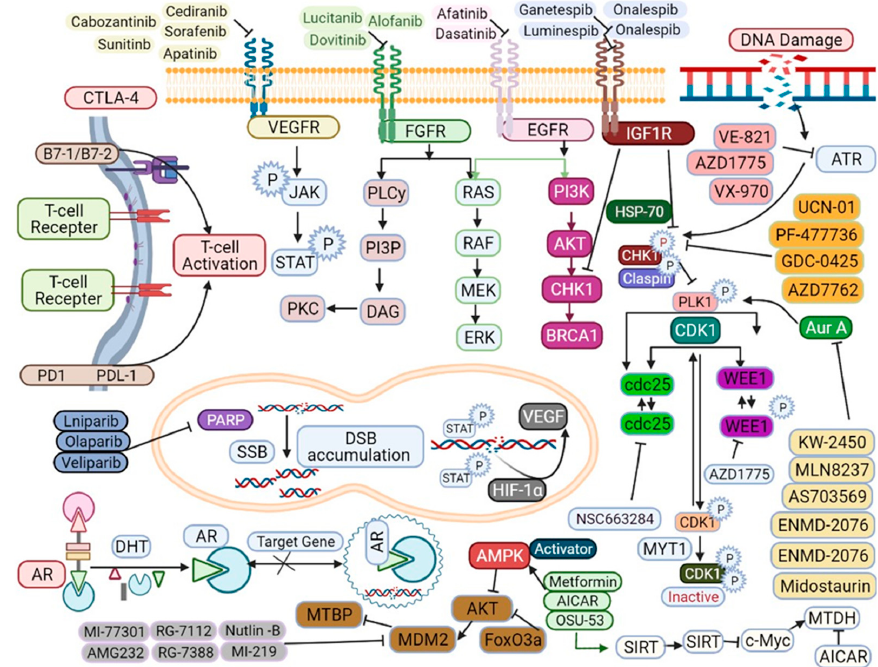
Figure 3. Representation of TNBC-associated molecular targets and their small molecule inhibitors. The arrows represent excitatory regulation, Reversible arrows represent reversible effect of regulation and the headed line arrows represent inhibitory effects.